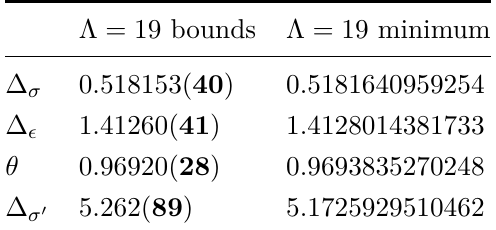
Table 6 . Allowed interval and minimum found at Λ = 19 using the N (∆ (cid:15) , ∆ σ , θ, ∆ σ 0 ) navigator where we assume ∆ 6 and ∆ 3 . The error presented in bold is σ 00 > (cid:15) 0 >